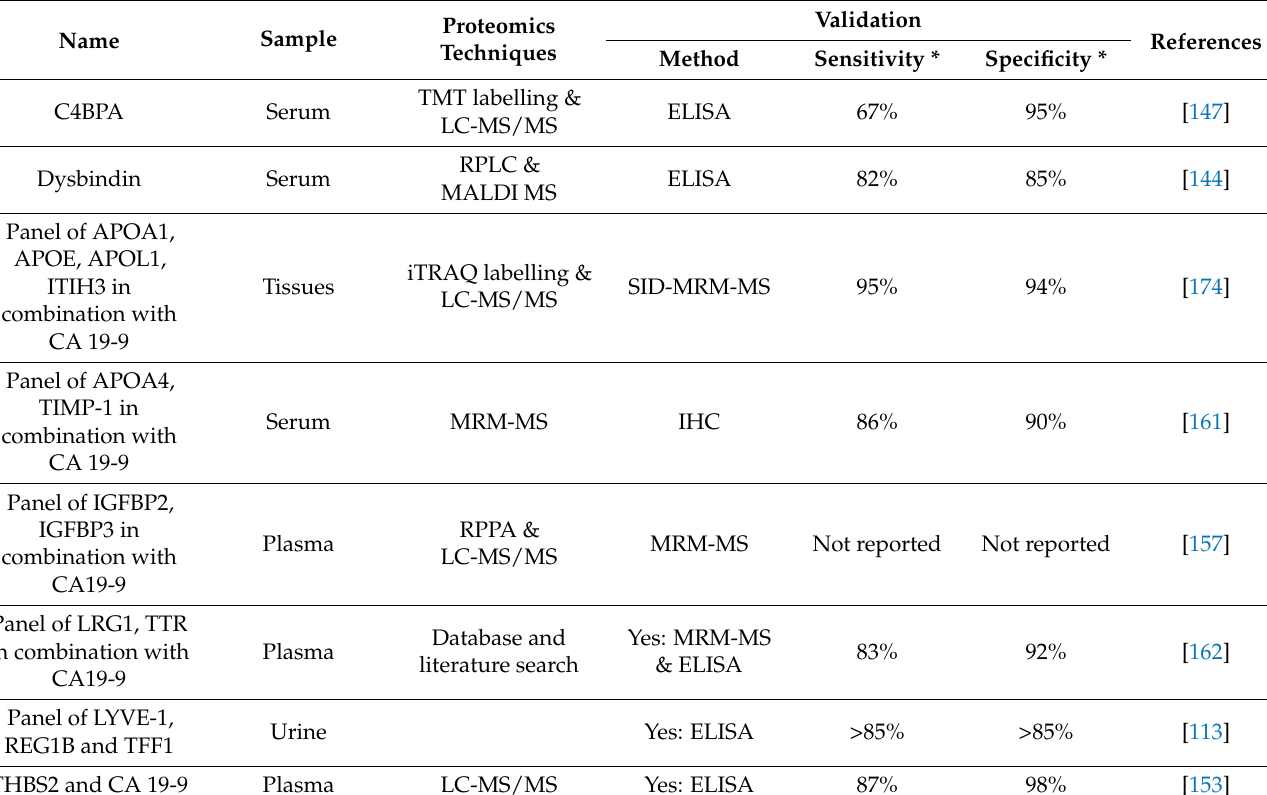
Table 2. Recently identified diagnostic biomarkers for PDAC using proteomics